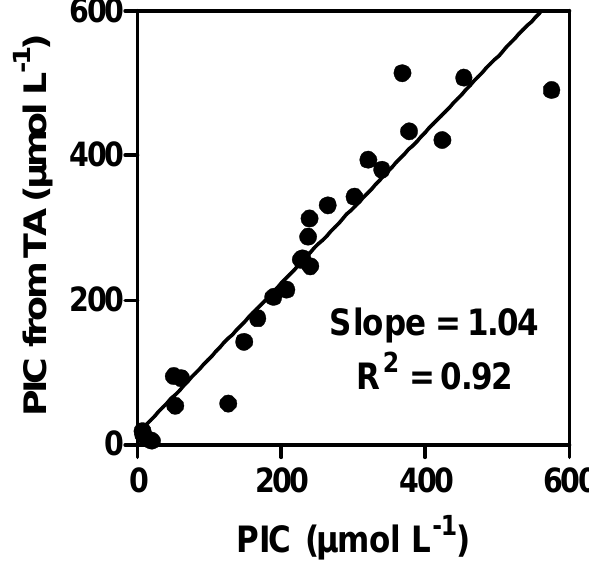
Fig. 1. Correlation between the PIC concentrations deduced from the TA measurement and those measured with a CHN analyzer. Ex- ample for the duplicate cultures at future CO 2 and 13 ◦ C ( n =25, slope = 1.042 ± 0.064, r 2